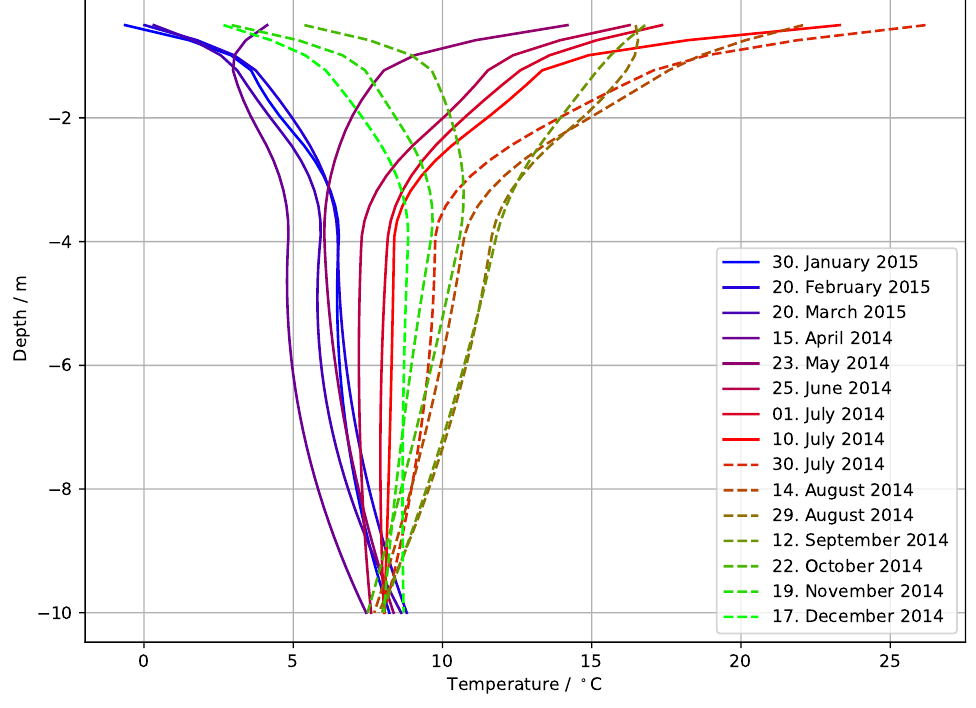
Figure 11. Seasonal soil temperatures at different depths from the surface according to the DTS measurements. During the summer (April–September) temperatures near the surface increase, and during winter months (October–March) the surface is the coldest. At 10 m depth the effect of the Sun is